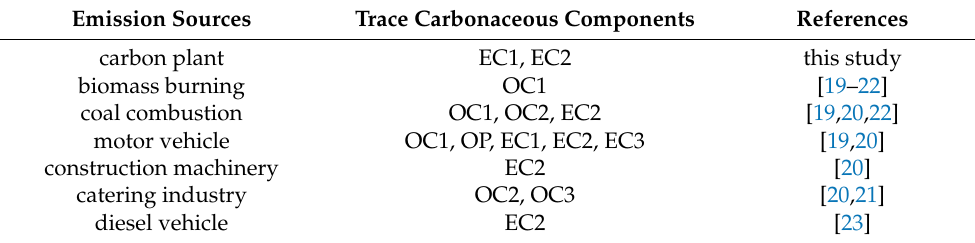
Table 3. Trace Carbon Components of Different Emission Sources.